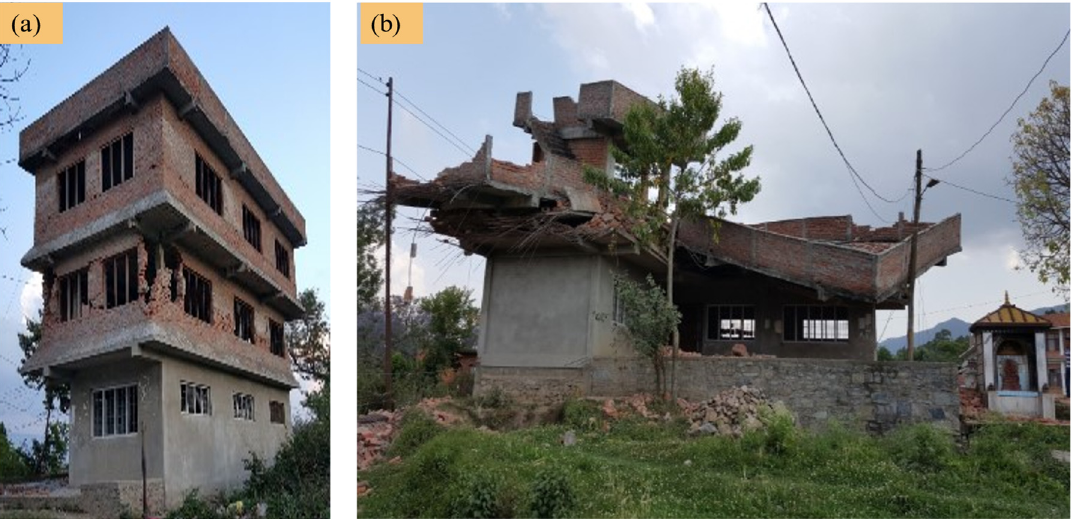
Figure 1. Damage to a residential building in Kathmandu by the 2015 Gorkha earthquake sequence: ( a ) after the 25 April mainshock; ( b ) after the 12 May aftershock (image courtesy of Krishna Devkota).